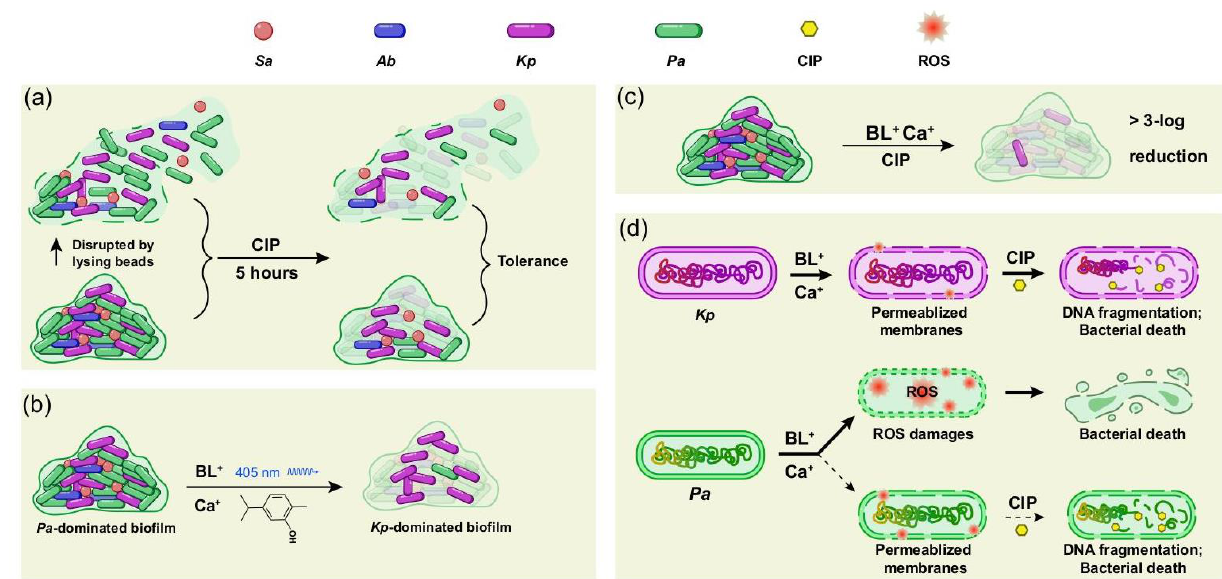
Figure 4. Schematic diagrams of anti-biofilm modalities. ( a ) Intact biofilm or disrupted biofilm showed similar tolerance to ciprofloxacin (CIP). ( b ) P. aeruginosa -dominated biofilm became K. pneumoniae -dominated after BL-Ca dual treatment. ( c ) The cocktail therapy of 80 J/cm 2 BL, 125 µg/mL Ca, and 10 µg/mL CIP showed strong anti-biofilm activity against the four-species biofilm. ( d ) BL-Ca treatment compromises the bacterial outer/cytoplasmic membranes of K. pneumoniae and allows entrance of CIP into the cells. CIP induces DNA fragmentation and cell death. Unlike K. pneumoniae , P. aeruginosa is mainly killed by ROS overwhelmingly induced by BL-Ca dual treatment. Bacteria survived the treatment could be further killed by CIP that enters the cells sufficiently following BL-Ca treatment. Sa : S. aureus ; Ec : E. coli ; Kp : K. pneumoniae ; Ab : A. baumannii ; Pa : P. aeruginosa .